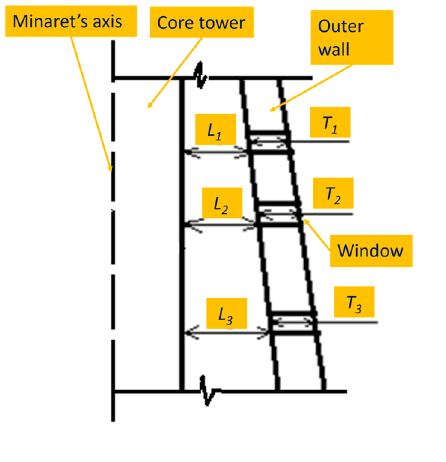
Table 2. Results of linear regression analysis for taper estimates.